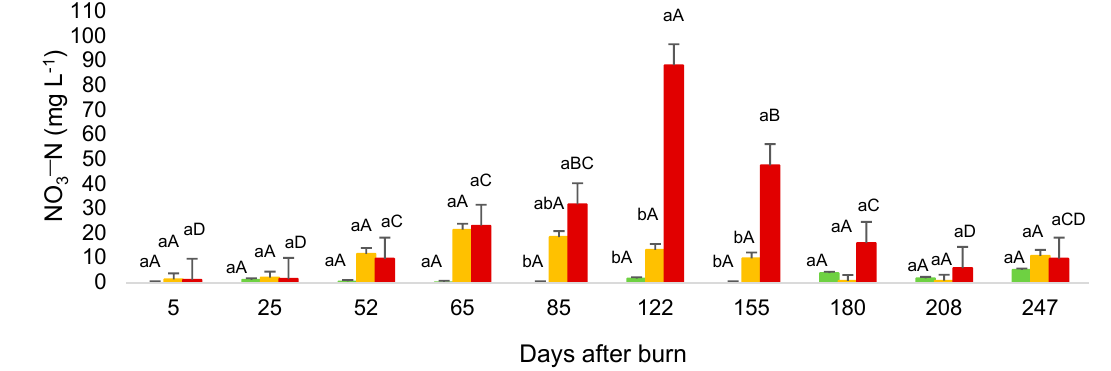
Figure 6. Treatment effect under control (C), moderate severity (MS), and high severity (HS) burn on nitrate (NO 3— N) (mg L − 1 ) concentration between 5 and 247 days after pile burning. Mean values followed by the different lowercase letters show significant differences within the same date. Mean values followed by the different uppercase letters show statistically significant differences within the same treatment. Significant differences were observed at p < 0.05 . Hanging bars represent the standard error. ( n = 5).